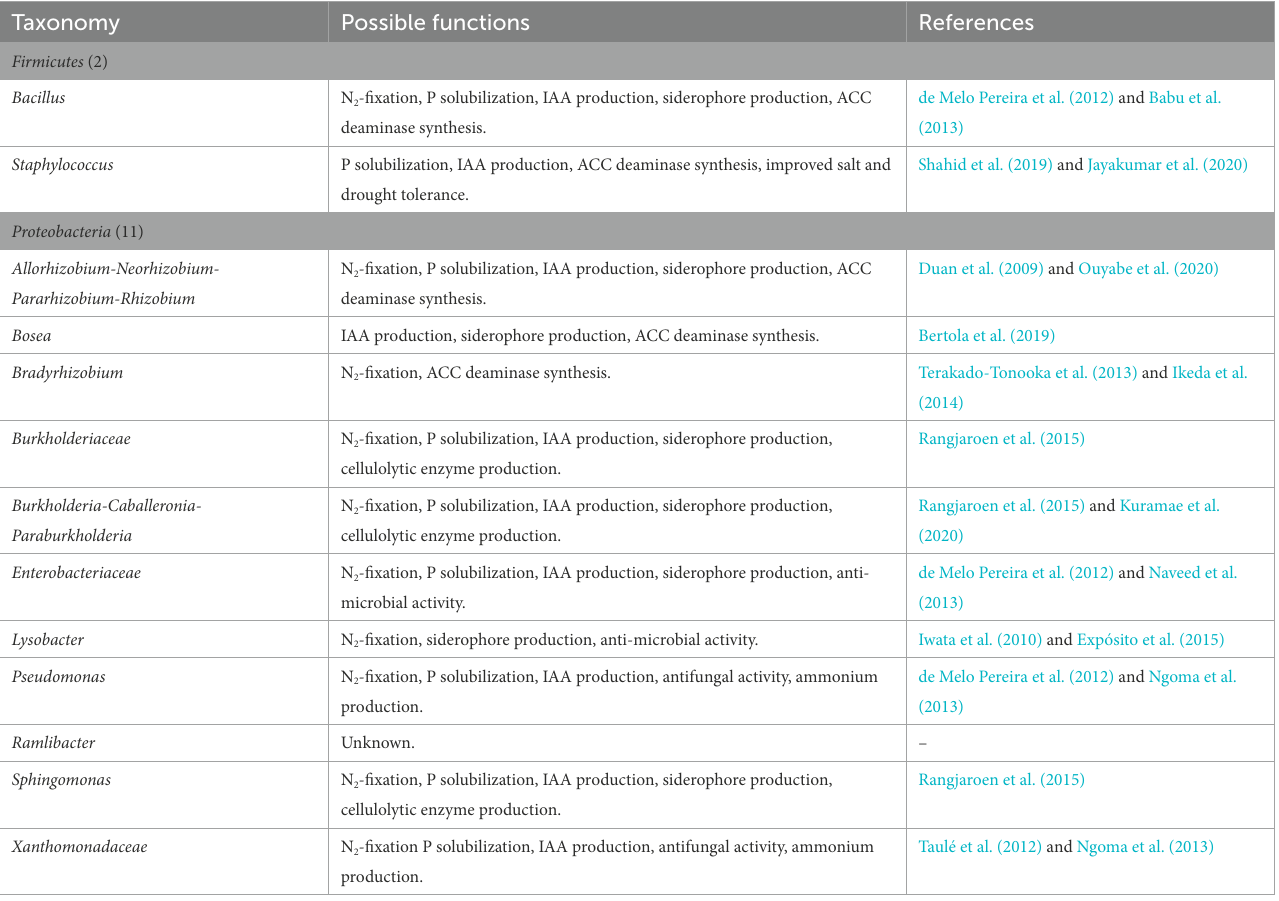
TABLE 4B The 27 taxa comprising core bacteria of the water yam ( Dioscorea alata L.) plant bacterial microbiota and their possible plant growth-promoting functions.